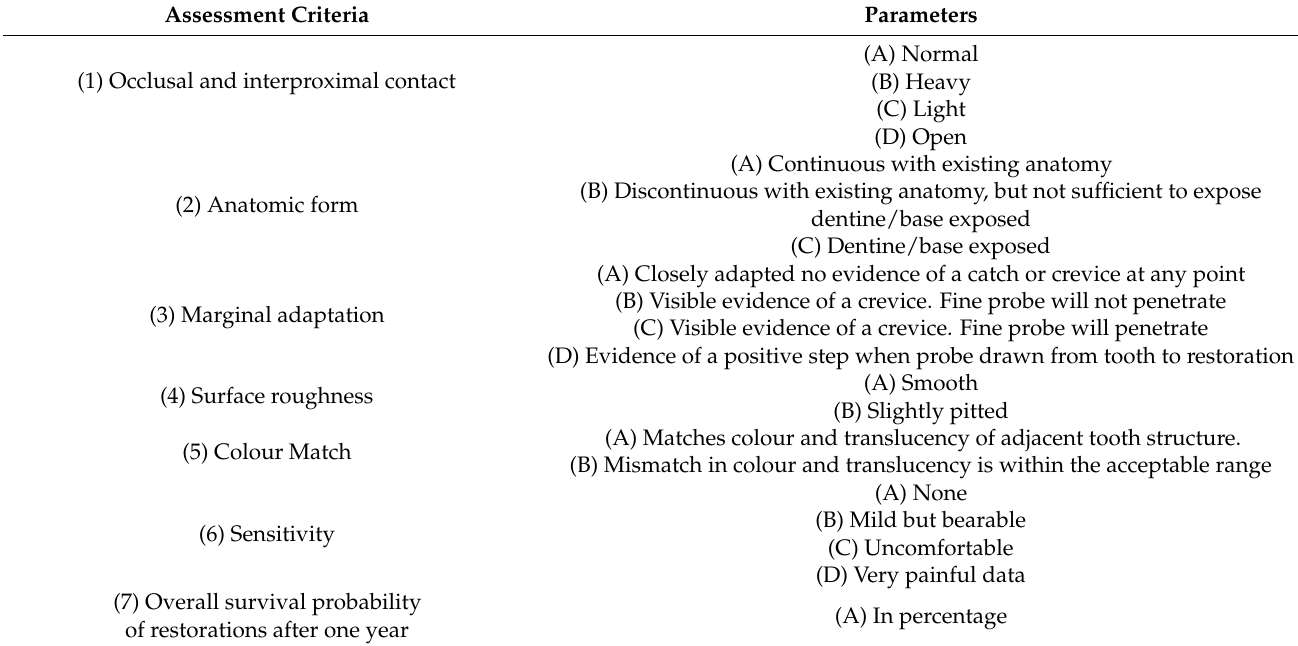
Table 3. The post-operative review assessment codes and criteria-USPHS criteria. Assessment